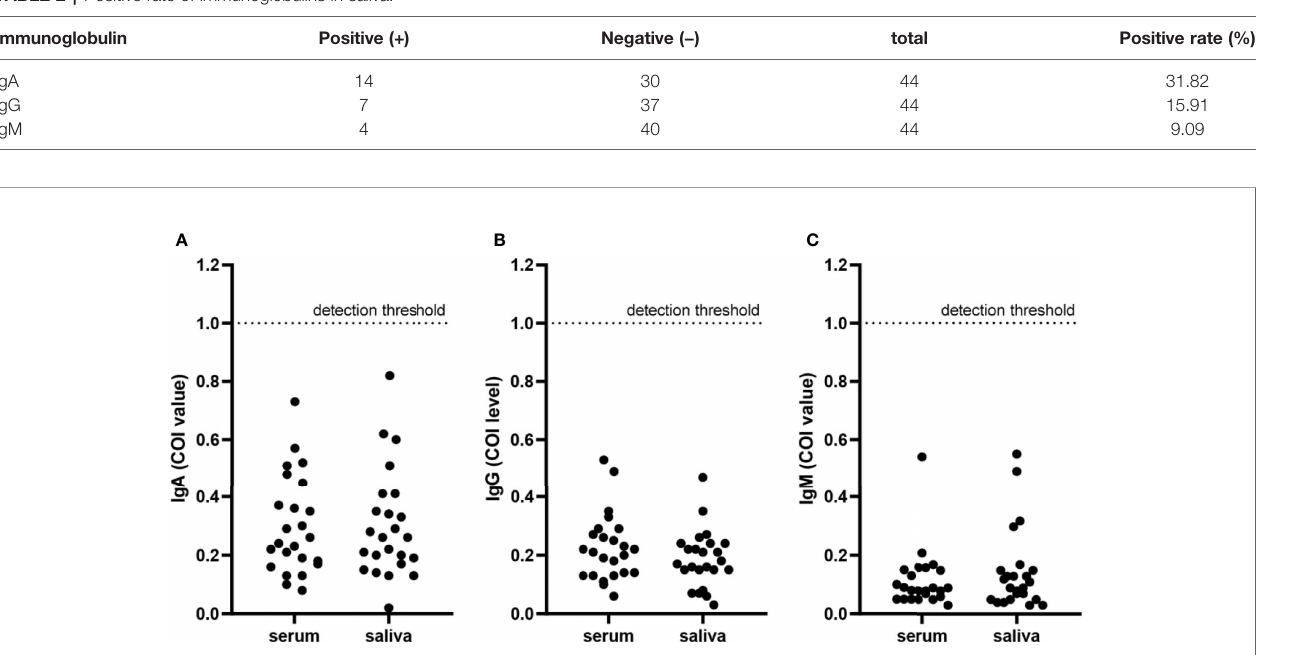
FIGURE 2 | Immunoglobulins in serum and saliva specimens from negative-control patients. Each point presented the COI value of IgA (A) , IgG (B) , and IgM (C) in serum or saliva specimens of each negative-control patient. The detection threshold was marked in each fi gure at COI = 1.